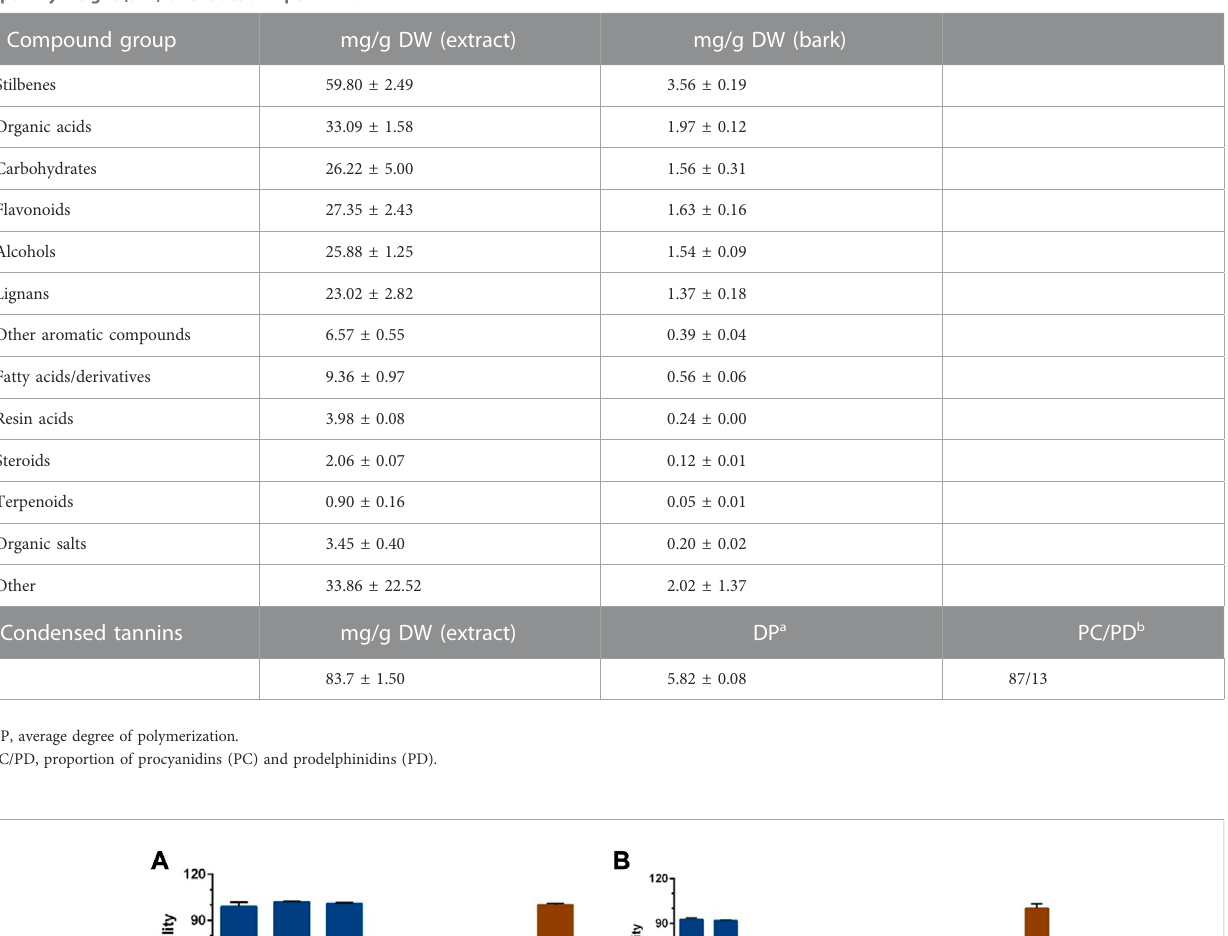
TABLE 1 Contents of the different compound groups in resin-treated TW extract. Condensed tannins were analyzed by UHPLC after thiolytic degradation of the tannins.OthercompoundgroupswereanalyzedbyGC.Thecontentisexpressedasmg/gdryextractanddrybark(mean±stdev).Theresultsarepresentedasmg/ g per dry weight (DW) of extract and per DW of bark.